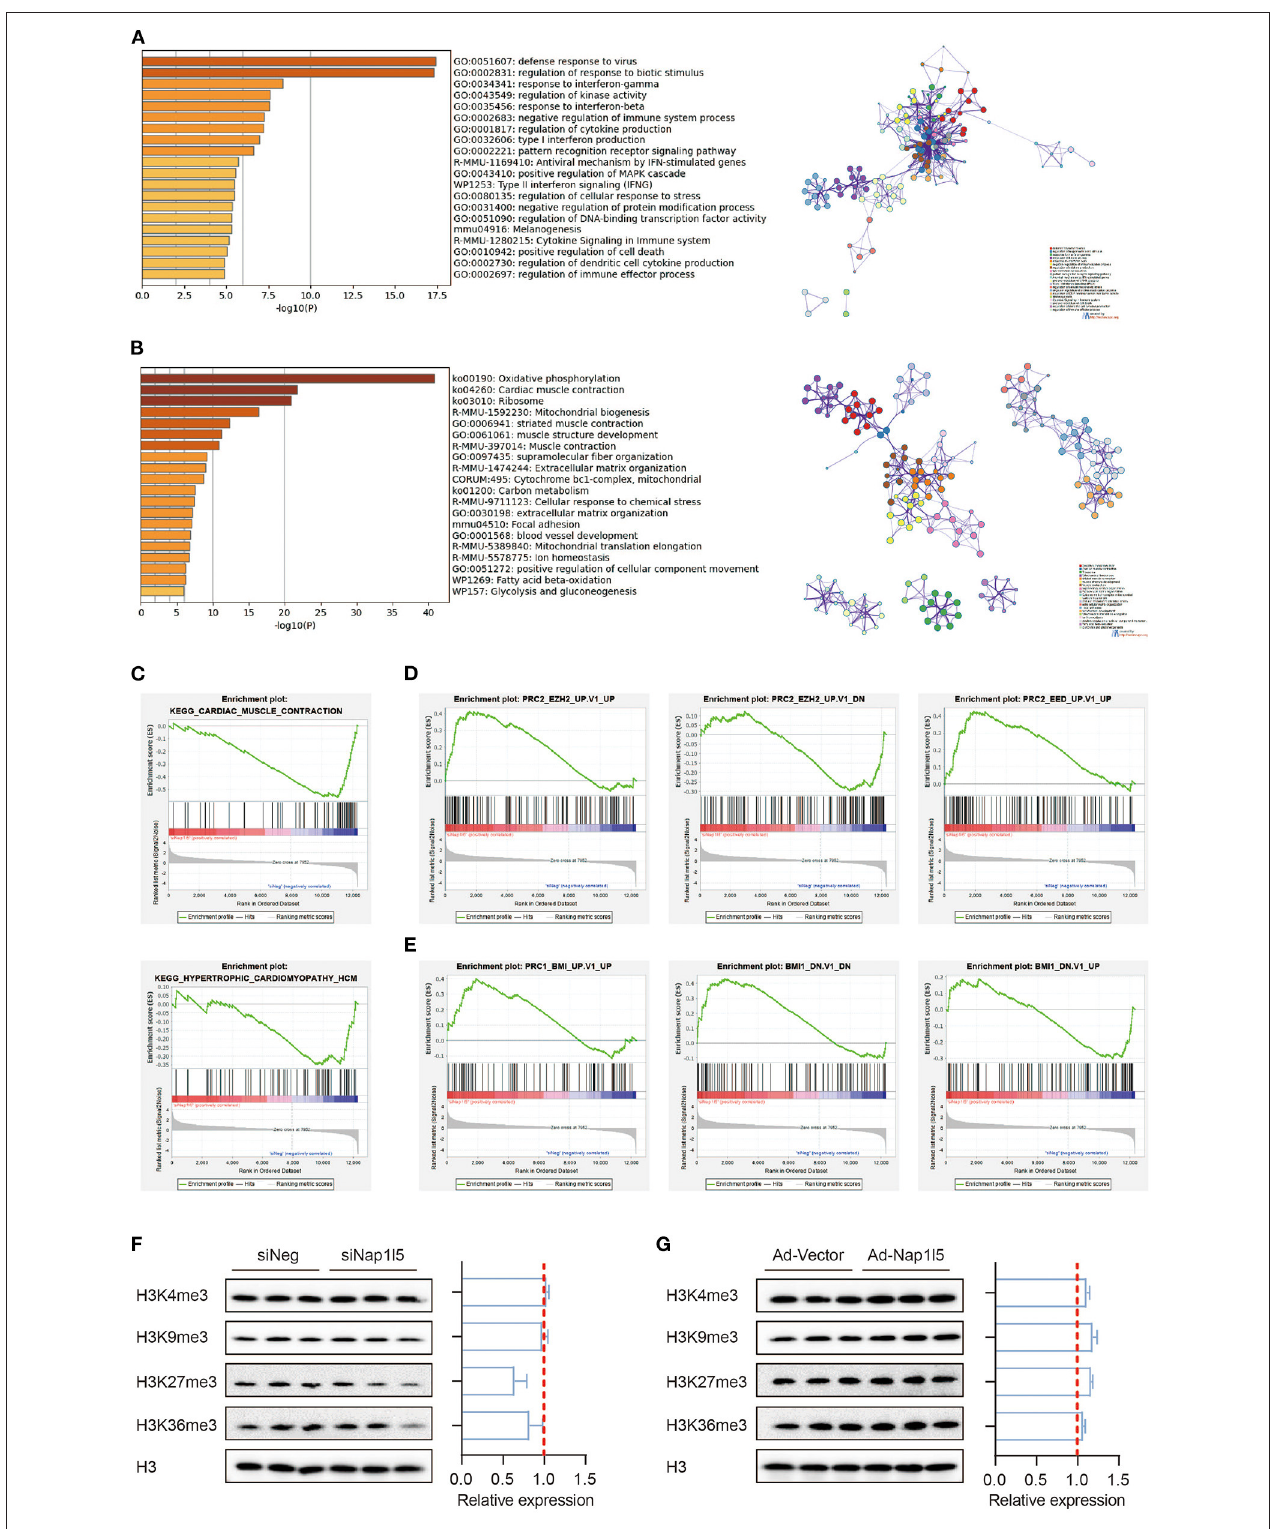
FIGURE 4 | NAP1L5 does not affect histone methylation-mediated epigenetic regulations. (A,B) GO analysis (left) and protein-protein interaction (PPI; right) of the upregulated (A) and down-regulated (B) genes after Nap1l5 knockdown. (C–E) Gene set enrichment analysis (GSEA) showing the enrichment pattern of pathways, including cardiac muscle contraction ( C ; upper), hypertrophic cardiomyopathy ( C ; lower), PRC2_EZH2_UP ( D ; left), PRC2_EZH2_DOWN ( D : middle), PRC2_EED_UP ( D ; right), PRC1_BMI_UP ( E ; left), PRC1_BMI_DOWN ( E ; middle), and BMI1_DOWN ( E ; right) after Nap1l5 knockdown. (F,G) Immunoblots (left) and quantification data (right) showing the impact of Nap1l5 knockdown (F) and Nap1l5 overexpression (G) on histone methylations at H3 K4, K9, K27, and K36 sites. n = 3.